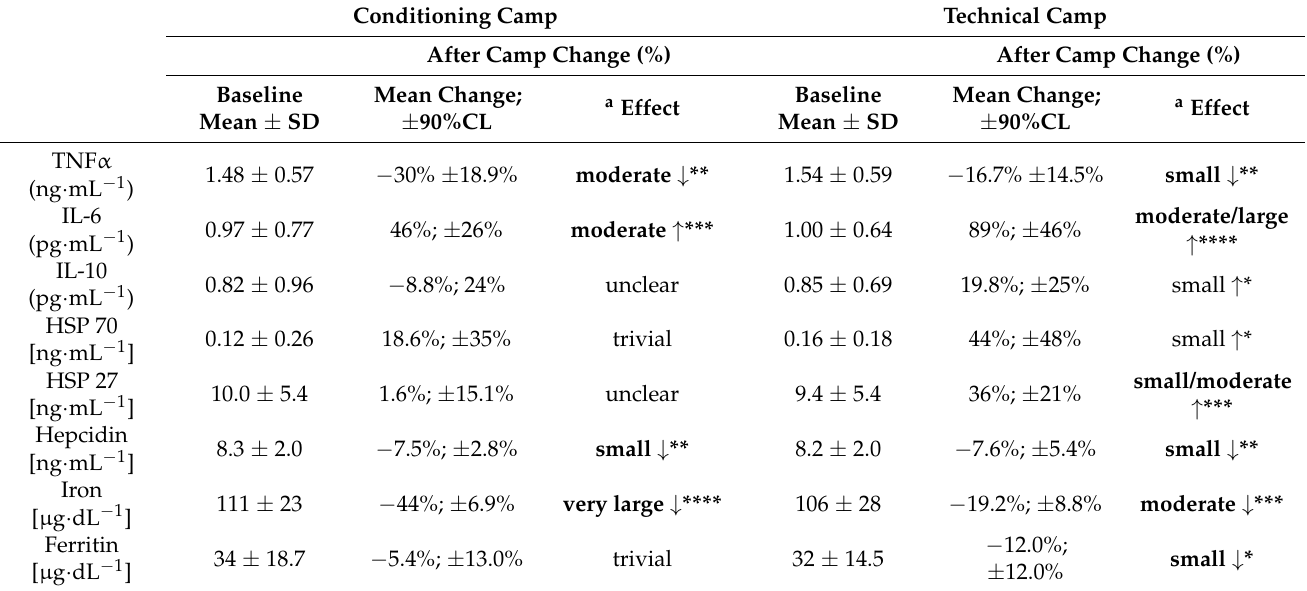
Table 4. The immunological responses induced by physical workload after conditioning and technical camp in all youth athletes (females and males; n = 26).